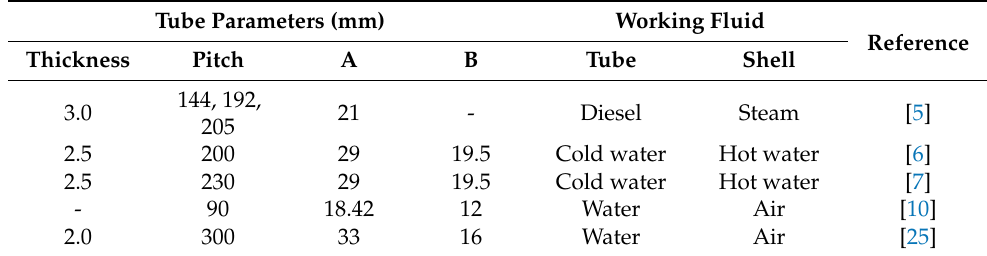
Table 1. Investigation of twisted tubes with various tube parameters and working